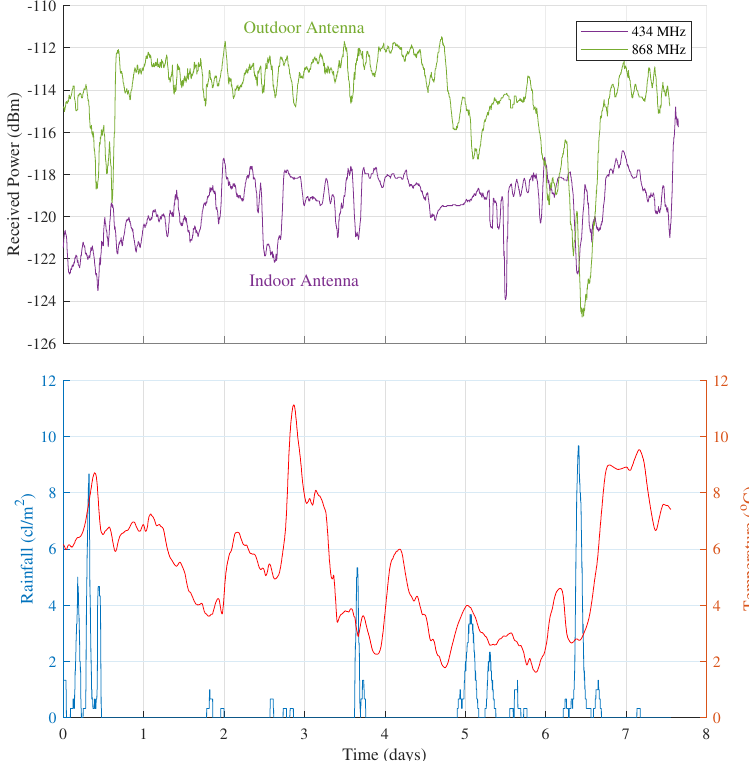
Figure 10. 7 days of outdoor received power measurements gathered at RX1 compared to temperature (red curve) and rainfall (blue curve)